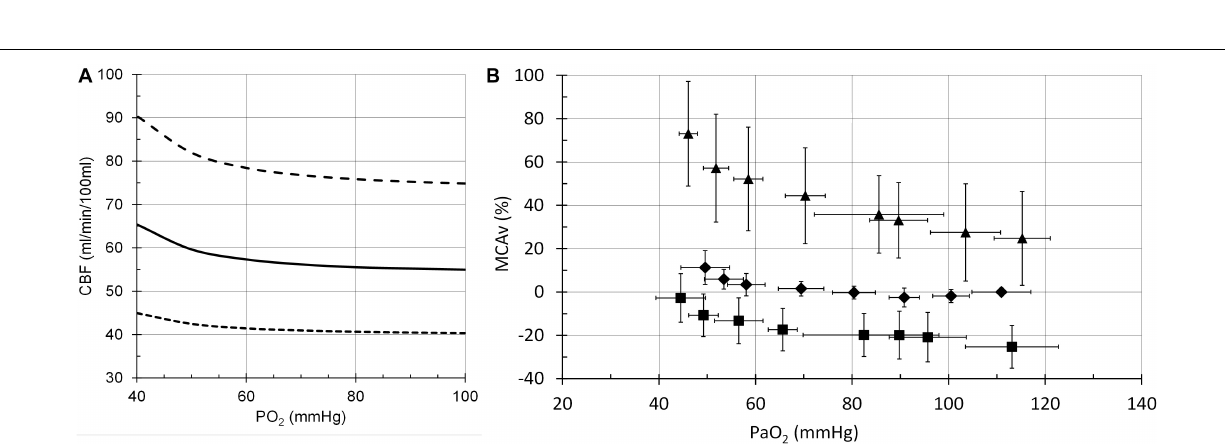
FIGURE 7 | Cerebral blood flow (CBF) responses to PO 2 . (A) Model responses at PCO 2 = 35 mmHg (dotted line), PCO 2 = 40 mmHg (solid line) and PCO 2 = 50 mmHg (dashed line). (B) Example transcranial Doppler (TCD) measurements of middle cerebral artery blood flow velocities at PCO 2 = 30 mmHg (squares), PCO 2 = 40 mmHg (diamonds) and PCO 2 = 50 mmHg (triangles) (Mardimae et al., 2012).